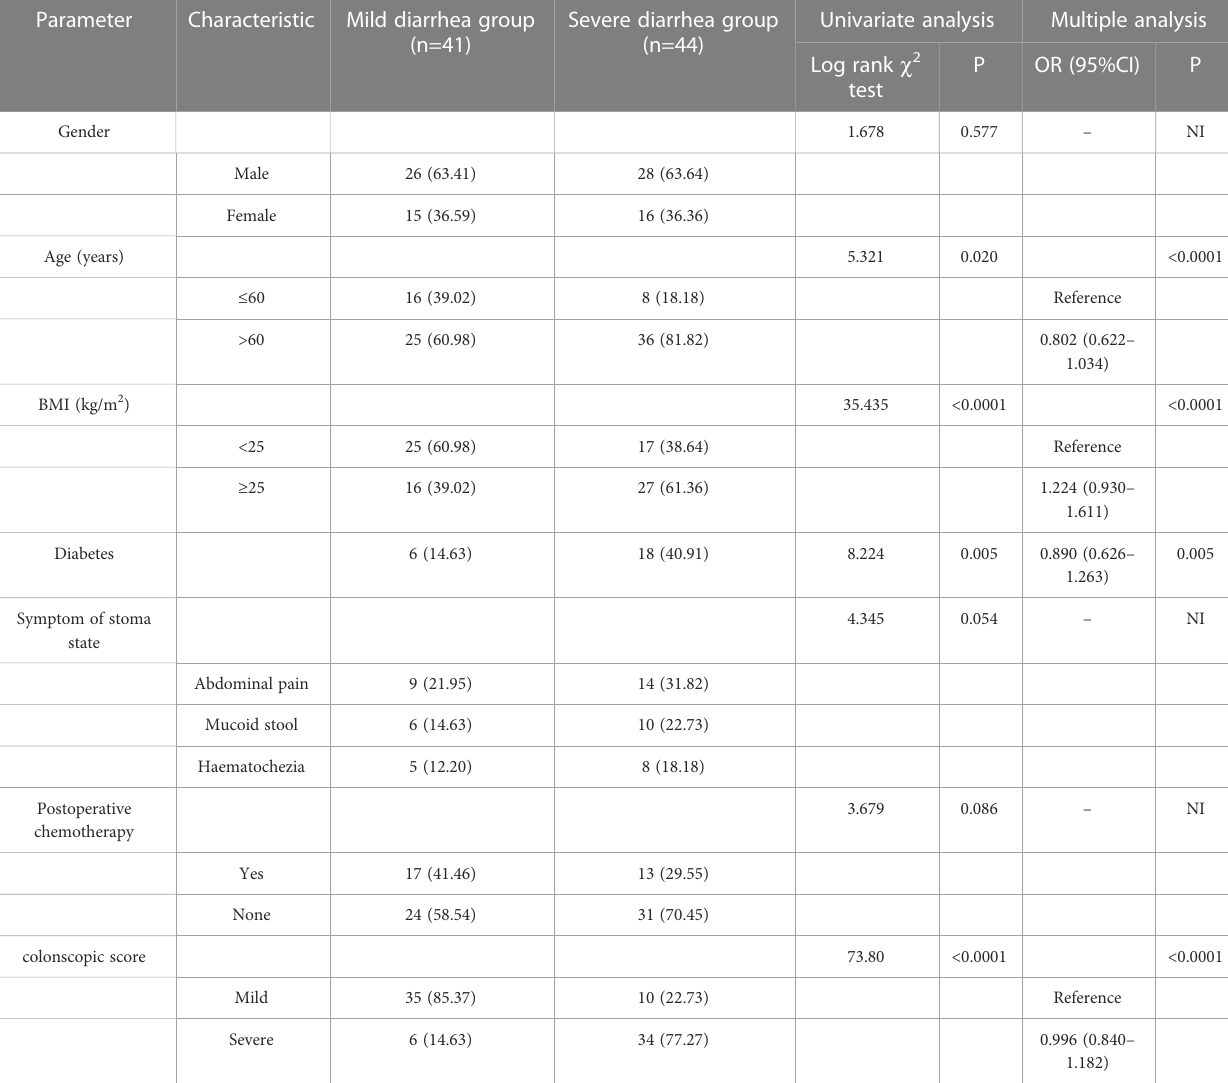
TABLE 3 Analysis of clinical data of patients with different diarrhea degree (n/%).